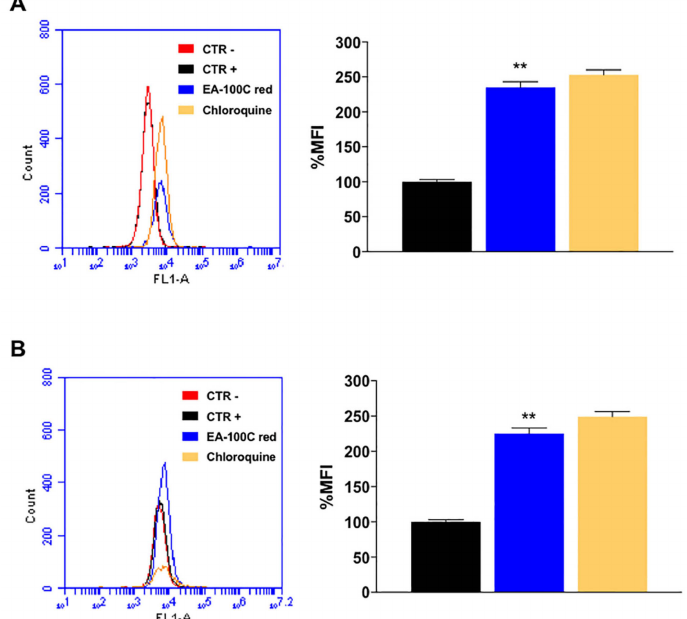
Figure 3. Effects of EA-100C red on mitochondrial membrane potential. Flow cytometric analysis of mitochondrial membrane potential by using Mitotracker Red, a dye which localizes in mitochondria and changes according to mitochondrial membrane potential variations due to oxidative stress. U87MG ( A ) and LN229 ( B ) cells were treated with EA-100C red for 72 h and H 2 O 2 for 1 h (left panels). CTR + stained untreated cells, CTR- unstained untreated cells. The % MFIs of control were calculated as described in ‘Materials and Methods’ and represented as columns (right panels). The experiments were performed at least three times and the results were always similar. Bars, SDs. ** p ≤ 0.001.